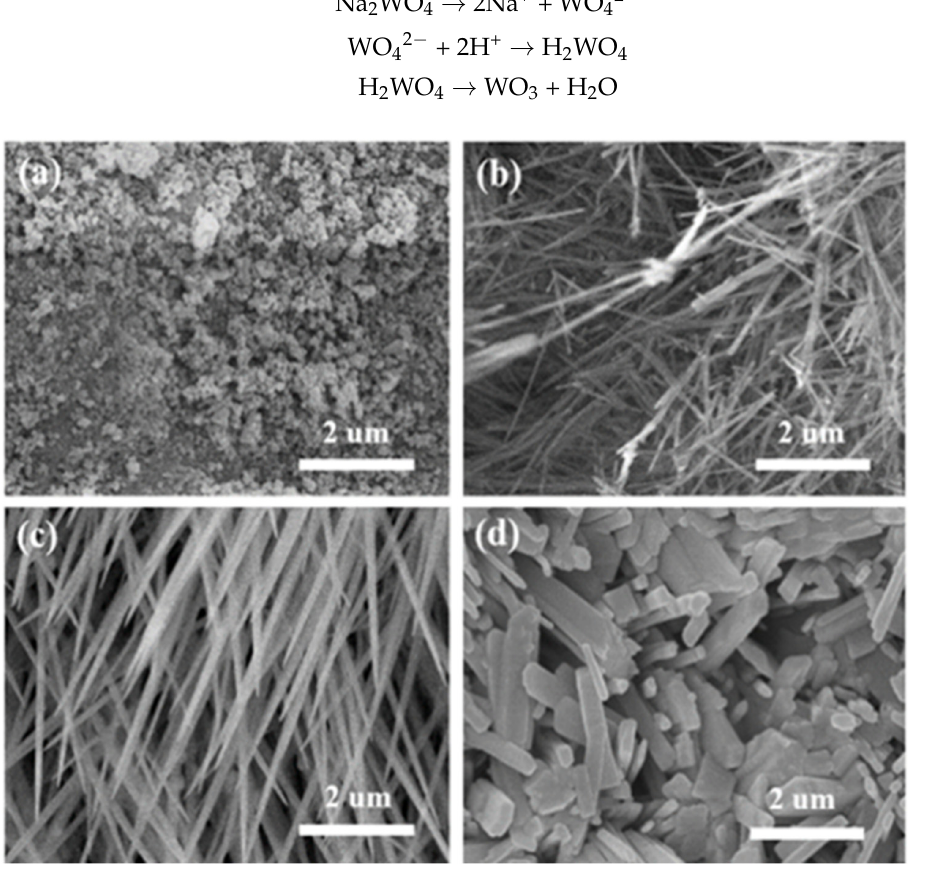
Figure 3. Growth control of the product morphology: ( a – d ) SEM images of the product with reaction time of 1 h, 4 h, 9 h and 18 h at the same reaction temperature 120 °C.